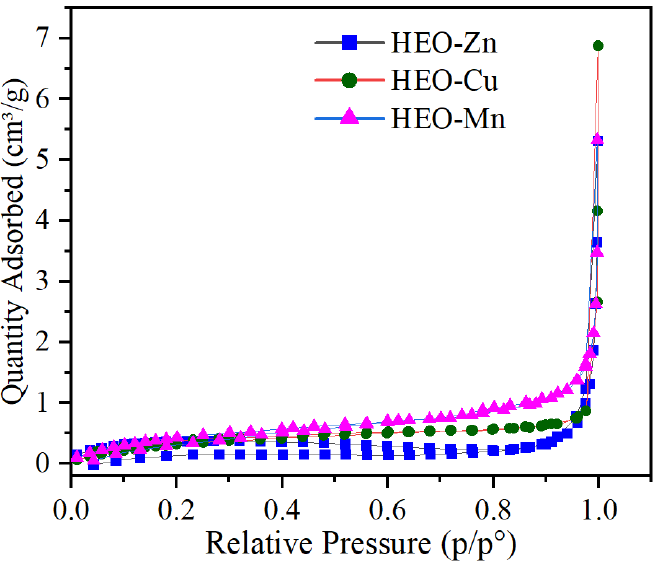
Figure 2. The nitrogen adsorption-desorption isotherm of HEO − Zn, HEO − Cu, and HEO − Mn. XPS experiments were also conducted to confirm the surface constitution and metal valence of these HE spinel ferrites. Figure 3b shows the full spectra of XPS patterns of HEO-Zn, HEO-Cu, and HEO-Mn samples. It is found that there are four clear and similar peaks, assigned to Fe 2p, Co 2p, Ni 2p, and Cr 2p, respectively (see Figure 3c–f). Normally, the peaks related to O were also found at the same position of 526.9 eV in all three spectra (Figure 3g). Due to the doping of different elements, these XPS spectra are of slight difference, as shown in Figure 3h–j. There are another three small peaks at about 1031.7 eV in the HEO-Zn spectrum, 936.1 eV in the HEO-Cu spectrum, and 655.5 eV in the HEO-Mn spectrum, respectively, which can be confirmed as the characteristic peaks of the Zn, Cu, and Mn elements. We can speculate that the doping elements of Zn, Cu, and Mn were successfully diffused into each spinel structure during the solid-phase reaction process, in accordance with the above EDS-mapping and XRD analyses [41]. The specific microstructures of HEO-Zn, HEO-Cu, and HEO-Mn samples were also observed by TEM, as shown in Figure 4. For all the samples, the ferrite powders are composed of spherical nanoparticles, suggesting the nanocrystalline feature of these spinel ferrites. Moreover, the submicron porous structures were also found by TEM, as shown in Figure 4a,b. Figure 4d–f shows the high-resolution TEM images of the ferrite powders selected randomly. It is seen that the lattice fringes can be clearly observed and the inter- planar distances of the three samples are all about 0.25 nm, which is equal to the inter-planar distance of (311) plane of NiCrFeO 4 or FeCoCrO 4 substances. This result is consistent with the XRD analysis, further proving that we have obtained the HE ferrites with a spinel structure through a solid-phase